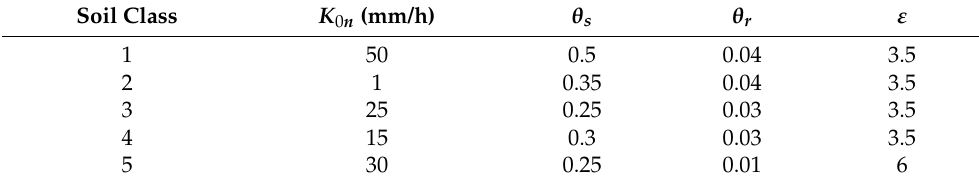
Table 4. Summary of the flood events considered in the calibration process of the Real-time Interactive Basin Simulator (RIBS) model. Maximum intensity refers to the mean rainfall intensity in the catchment.